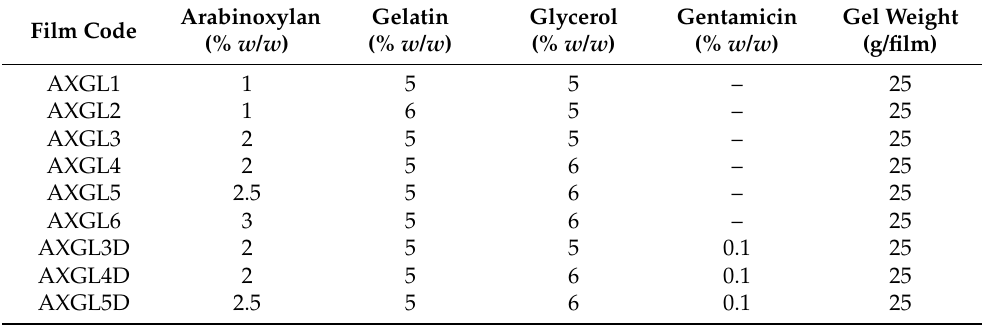
Table 1. Composition of the casting gels used to prepare arabinoxylan-gelatin (AX-GL)